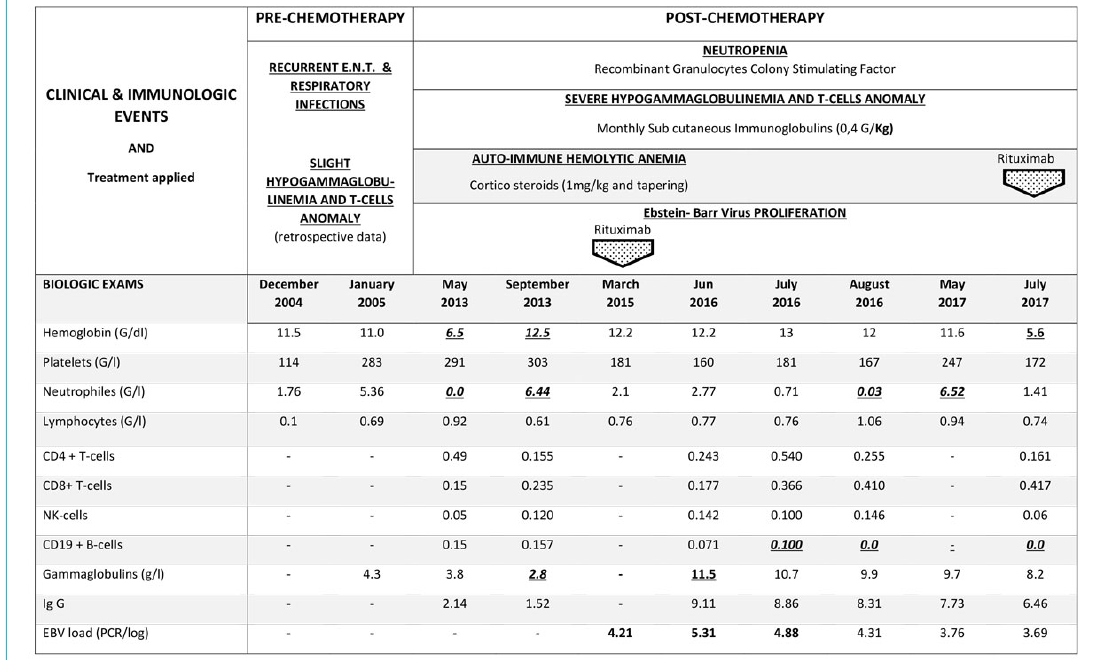
Figure 3: Clinical course and biological test